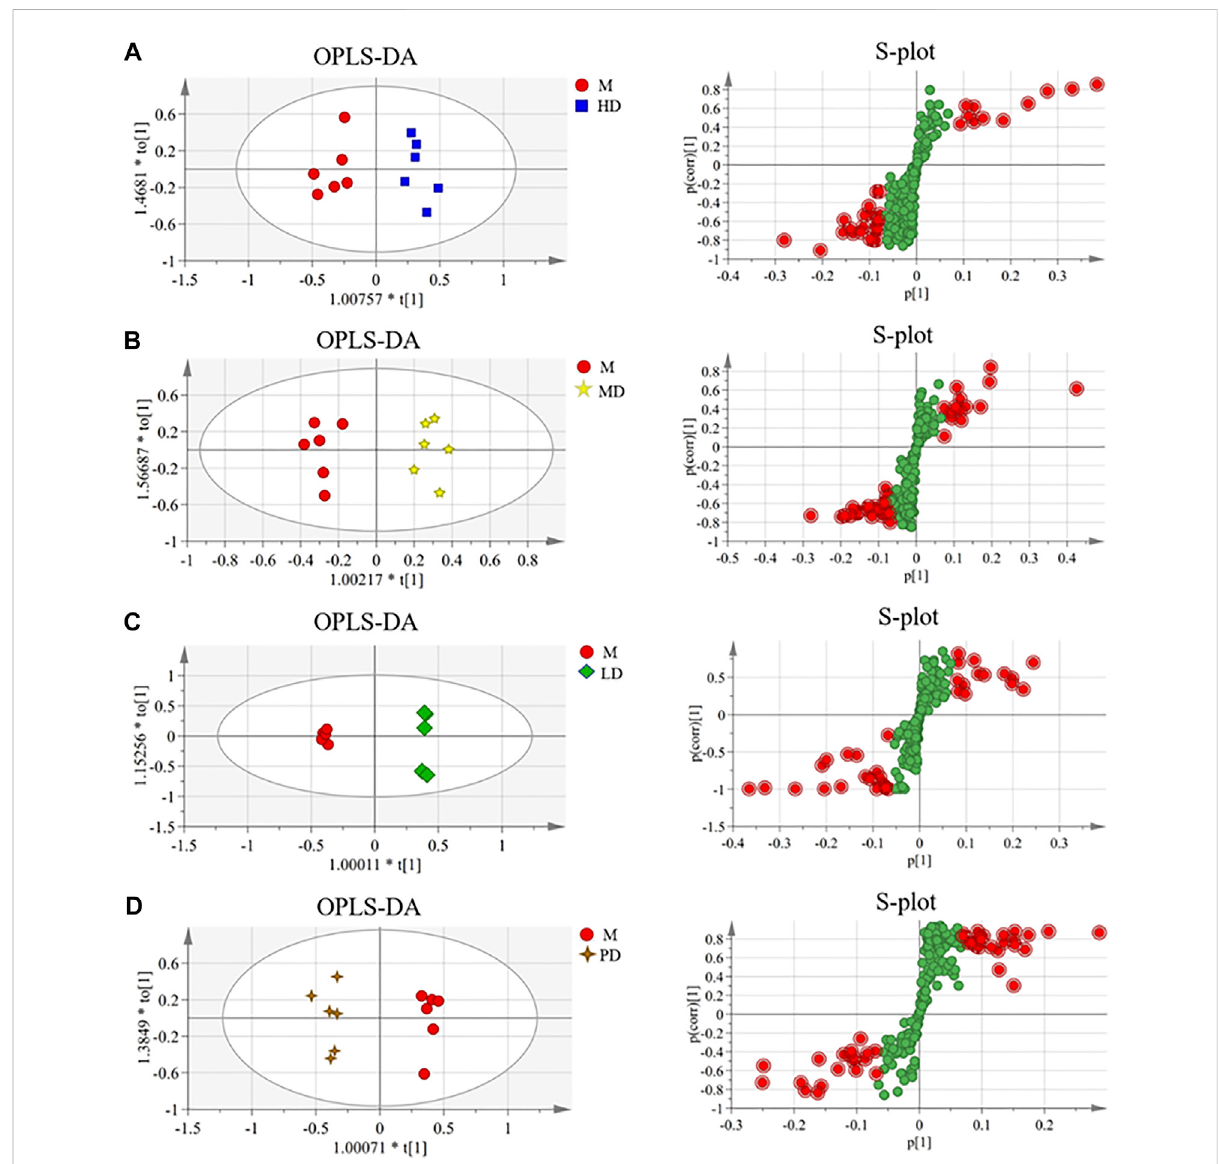
FIGURE 3 OPLS-DA scores and S-plot of the liver metabolite group of CUMS mice in each administration group ( n = 6). (A) HD group vs. M group (R 2 X = 0.655, R 2 Y = 0.927, and Q 2 = 0.568); (B) MD group vs. M group (R 2 X = 0.759, R 2 Y = 0.959, and Q 2 = 0.422); (C) LD group vs. M group (R 2 X = 0.762, R 2 Y = 0.999, and Q 2 = 0.968); (D) PD group vs. M group (R 2 X = 0.777, R 2 Y = 0.978, and Q 2 =